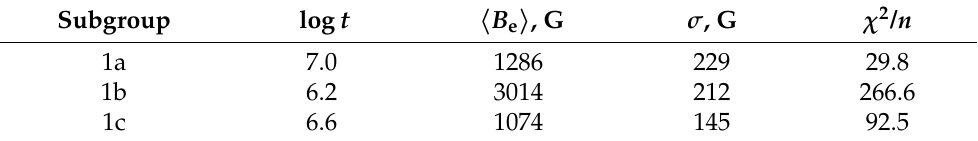
Table 1. Root-mean-square fields of magnetic stars in different subgroups of the Orion OB1 association.